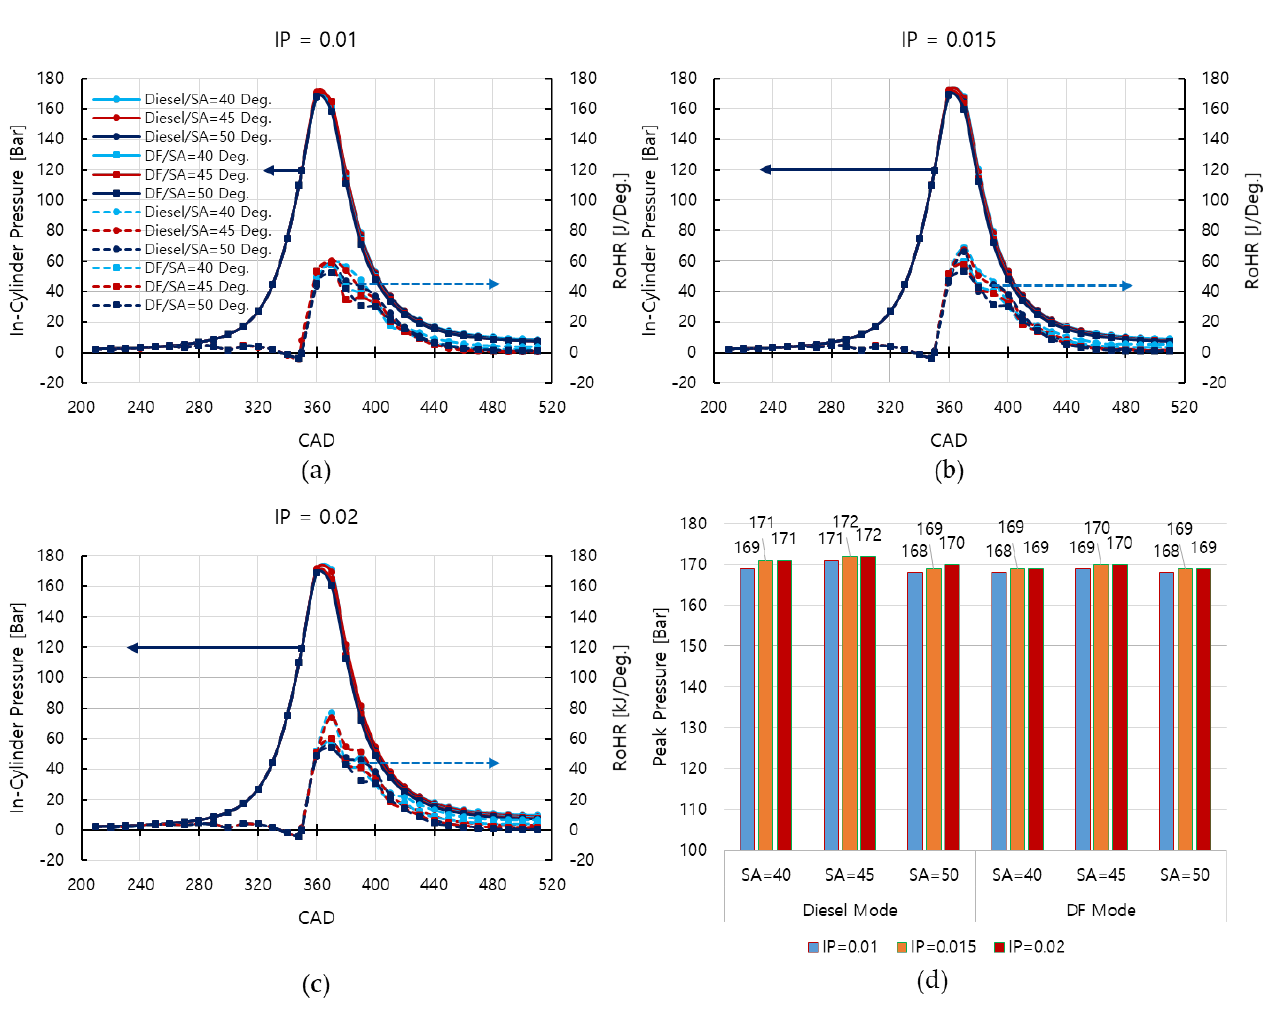
Figure 9. In-cylinder pressure and RoHR diagrams in the IP = 0.01 m case ( a ), IP = 0.015 m case ( b ), IP = 0.02 m case ( c ), and peak pressure in all cases ( d ).